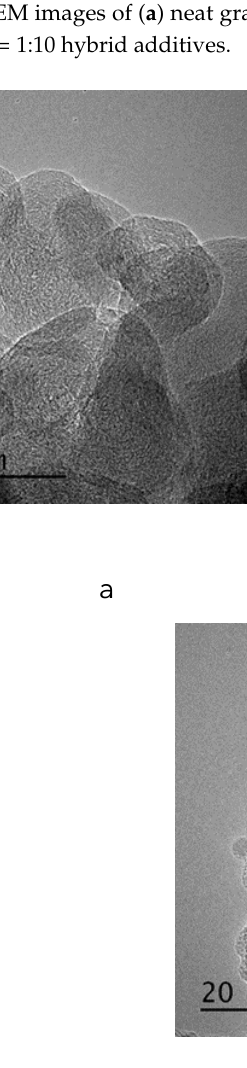
Figure 5. TEM images of ( a ) neat GNP, ( b ) and ( c ) its hybrid of Si:GNP = 1:10.